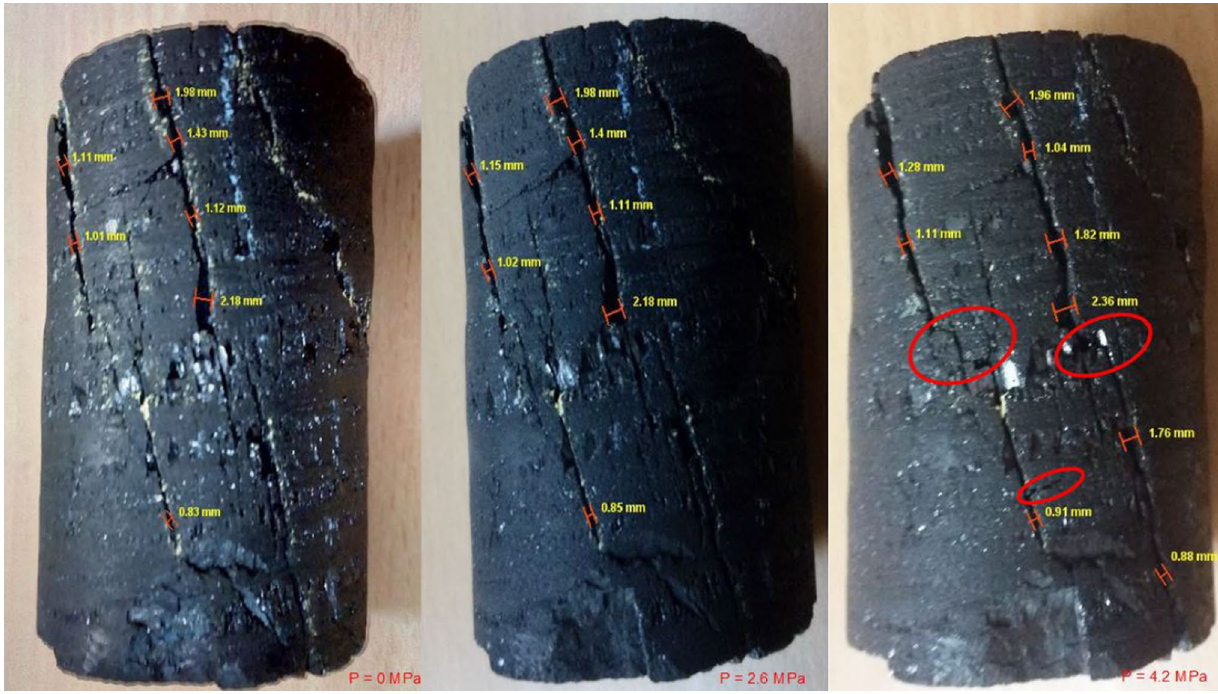
Fig. 15 Change in cleat spacing with gas